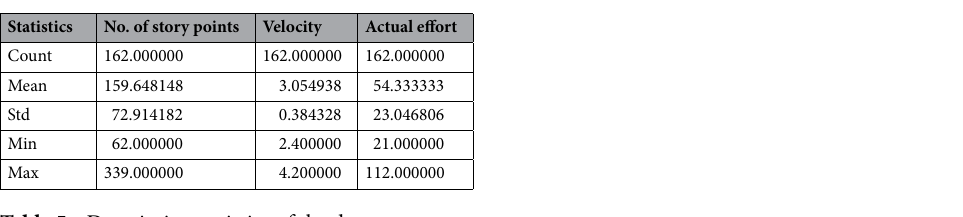
Table 5. Descriptive statistics of the